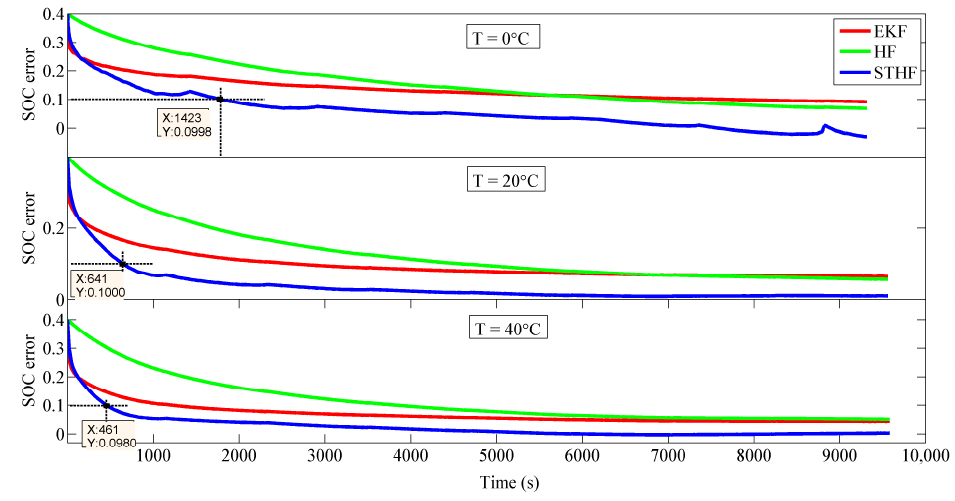
Figure 16. Estimation errors of STHF, HF, and EKF with an initial error.